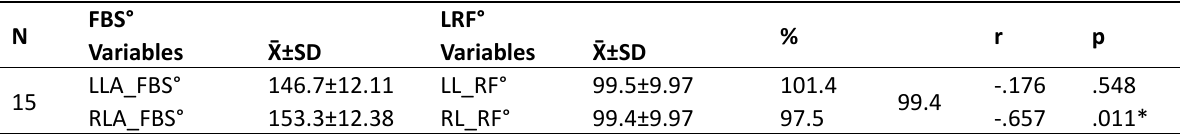
Table 4. Functional active flexibility “Forward-Backward Split Technique (FBS°)” during execution of techniques requiring mobility “Leg Raise Forward (LRF°)”